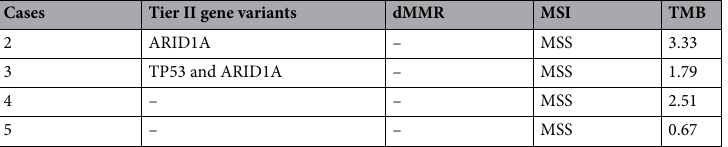
Table 3. Genetic analyses of 4 patients with clear cell carcinoma of the abdominal wall. Tier II gene variants: variants of potential clinical significance. dMMR mismatch repair deficiency, MSI microsatellite instability, MSS microsatellite stability, TMB tumor mutation